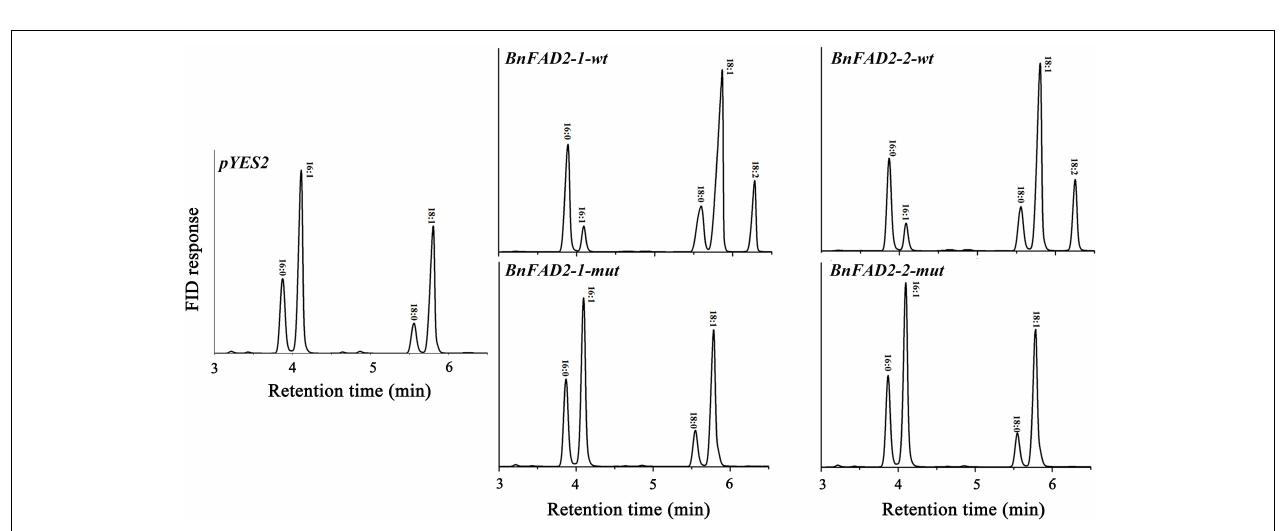
FIGURE 2 | Amplification in registered rapeseed varieties using different primer combinations. Lanes 1–22 refer to the numbered varieties listed in Supplementary Table S2 . Lane 23, N1379T; Lane 24, H 2 O (negative control). M, DNA marker. There were three standard bands in the M lane representing the 750, 500, and 250 bp band sizes.